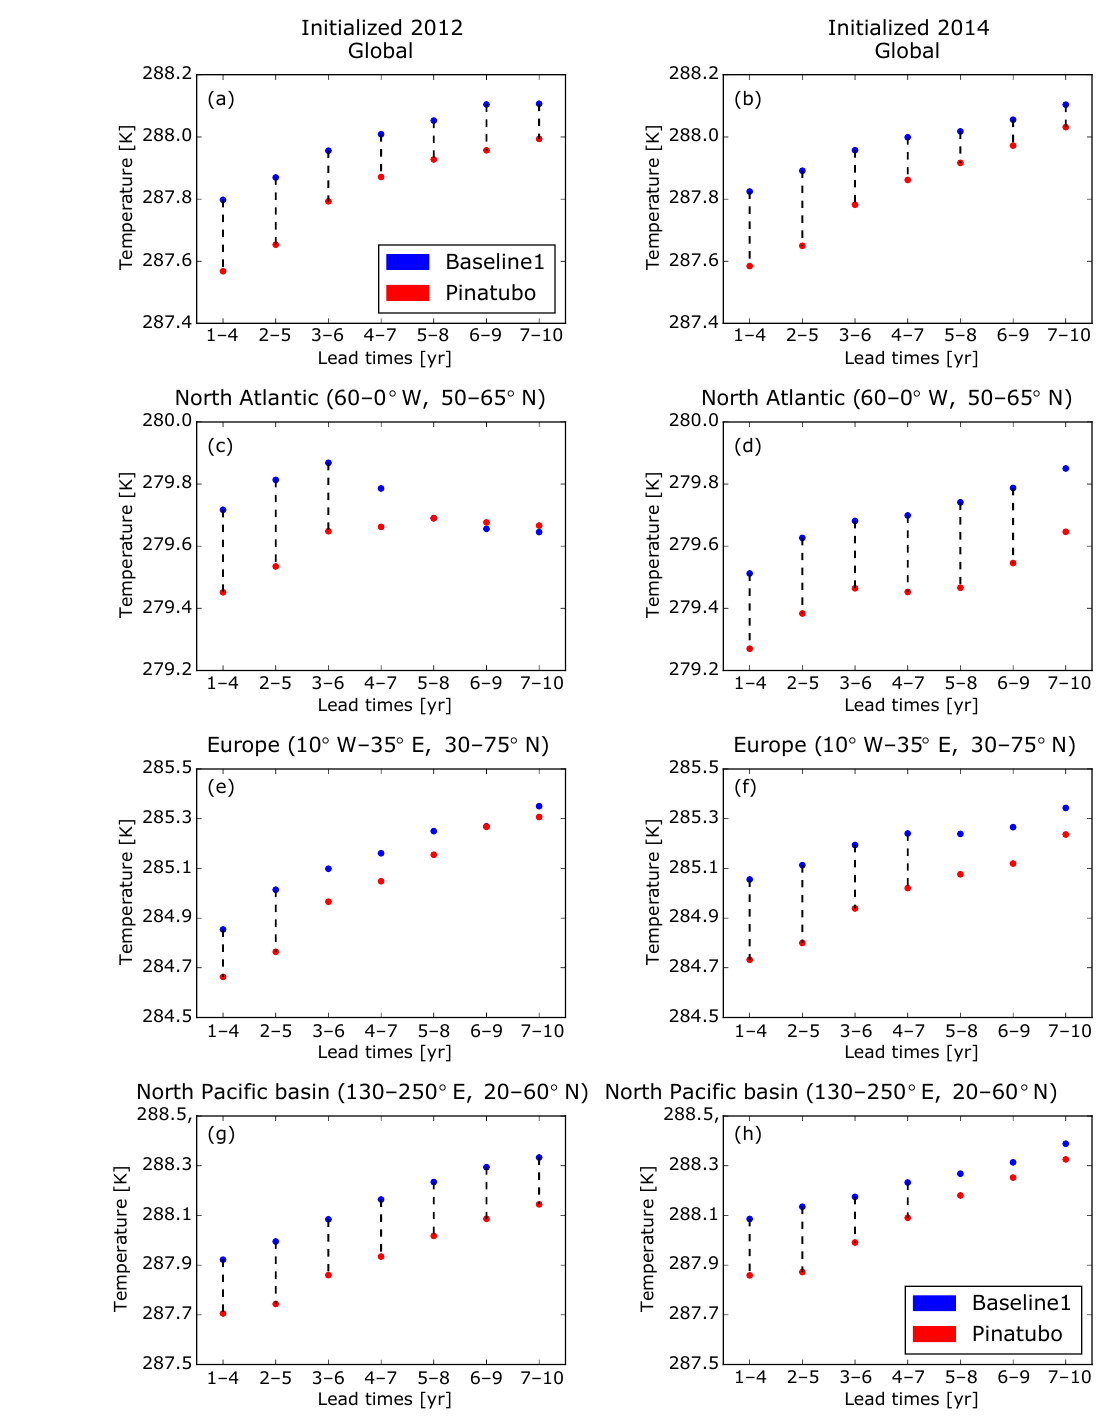
Figure 2. Time series of 4-year running mean ensemble forecast of near-surface air temperature (TAS) anomalies. The blue shows values without volcanic eruption, and red with a Pinatubo-like eruption. (a, c, e, g) Experiments initialized in 2012 and (b, d, f, h) those initialized in 2014. (a, b) Global mean, (c, d) North Atlantic (60 ◦ W–0 ◦ E, 50–65 ◦ N), (e, f) Europe (10 ◦ W–35 ◦ E, 30–75 ◦ N), and (g, h) North Pacific basin (130–250 ◦ E, 20–60 ◦ N). Dashed lines indicate significant differences between the values at the 5% level.